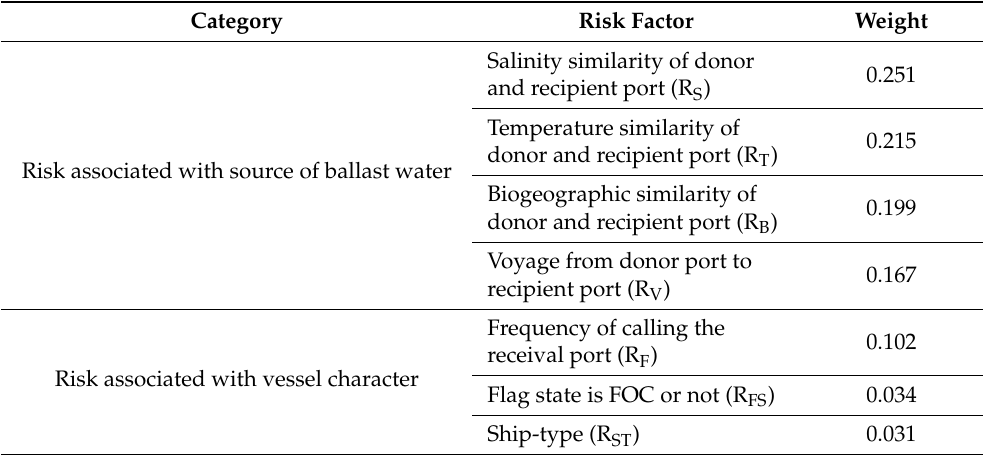
Table 2. Risk factors and its weighting coefficients in the risk assessment model.